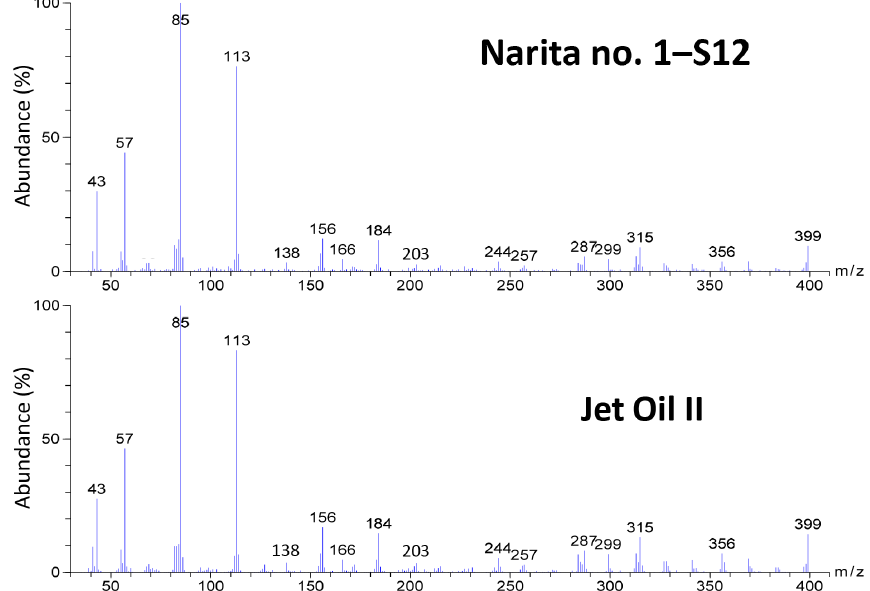
Figure 8. Mass spectra of a nanoparticle sample collected during the daytime at the Narita International Airport (sample no. 1, 9–13 Febru- ary 2018; S12, diameter: 18–32nm) and Jet Oil II at 23.51min of the TD–GC-MS chromatograms. The chromatographic peaks are indicated in Fig. 7. The instrument background spectrum was subtracted for the Narita no. 1–S12